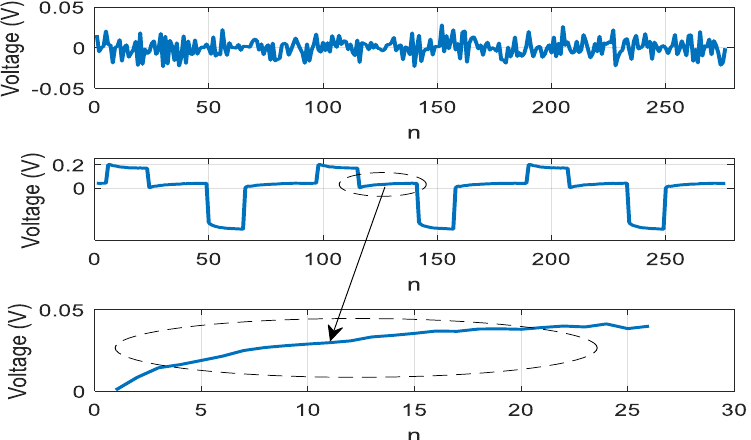
Figure 11. Dependence of the extracted signal on discrete time 𝑛 = 𝑡 Δ𝑡⁄ , Δ𝑡 = 1𝜇𝑠, implying an extraction obtained using the combined criterion based on generalized skewness, generalized kurtosis and second order adaptation algorithm.